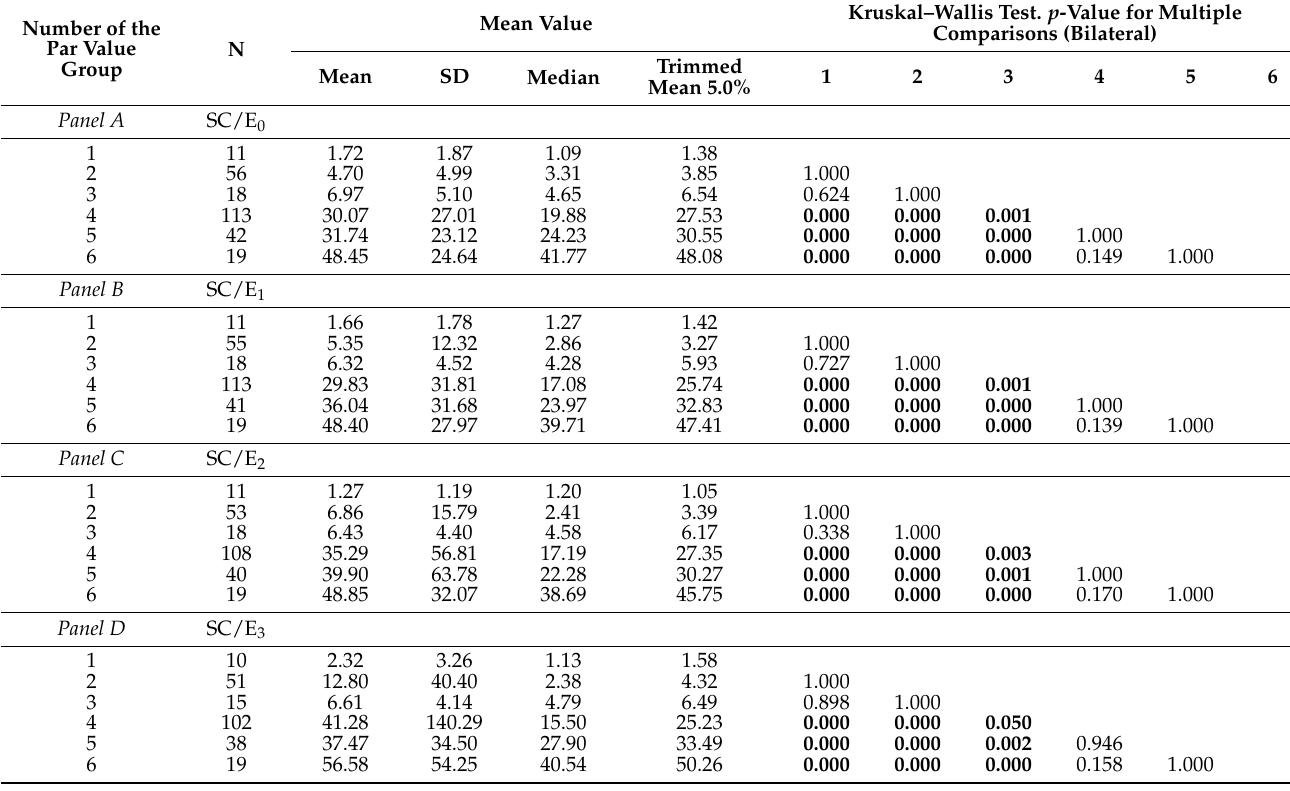
Table 10. Share-capital-to-equity ratio in subsequent years of issue depending on PaV. Kruskal–Wallis Test. p -Value for Multiple Mean Value Comparisons